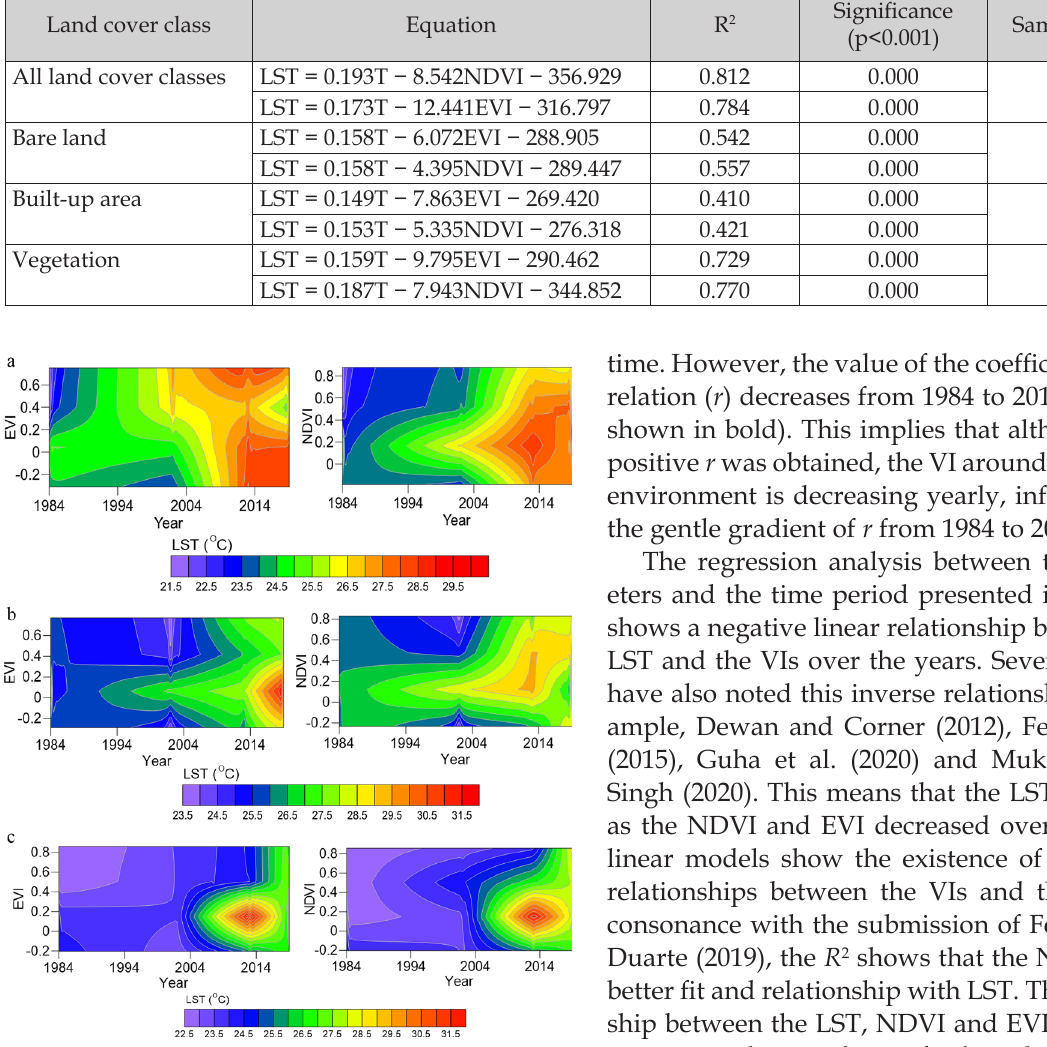
Fig. 11. Temporal relationship between EVI and NDVI and LST in bare land class (a), in built-up area class (b) and in vegetation class